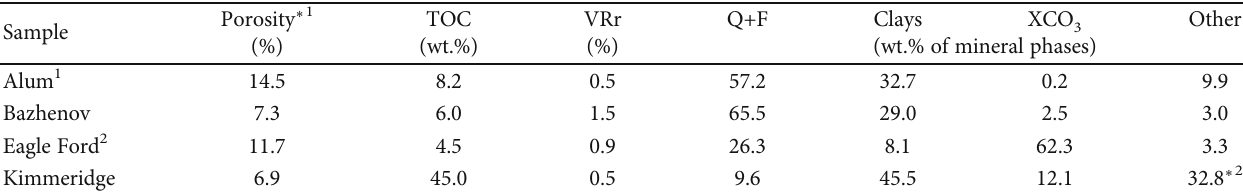
Table 1: Porosity, total organic carbon content (TOC), vitrinite re fl ectance (VRr), and mineral composition (XRD meas.) for the samples used in this study.